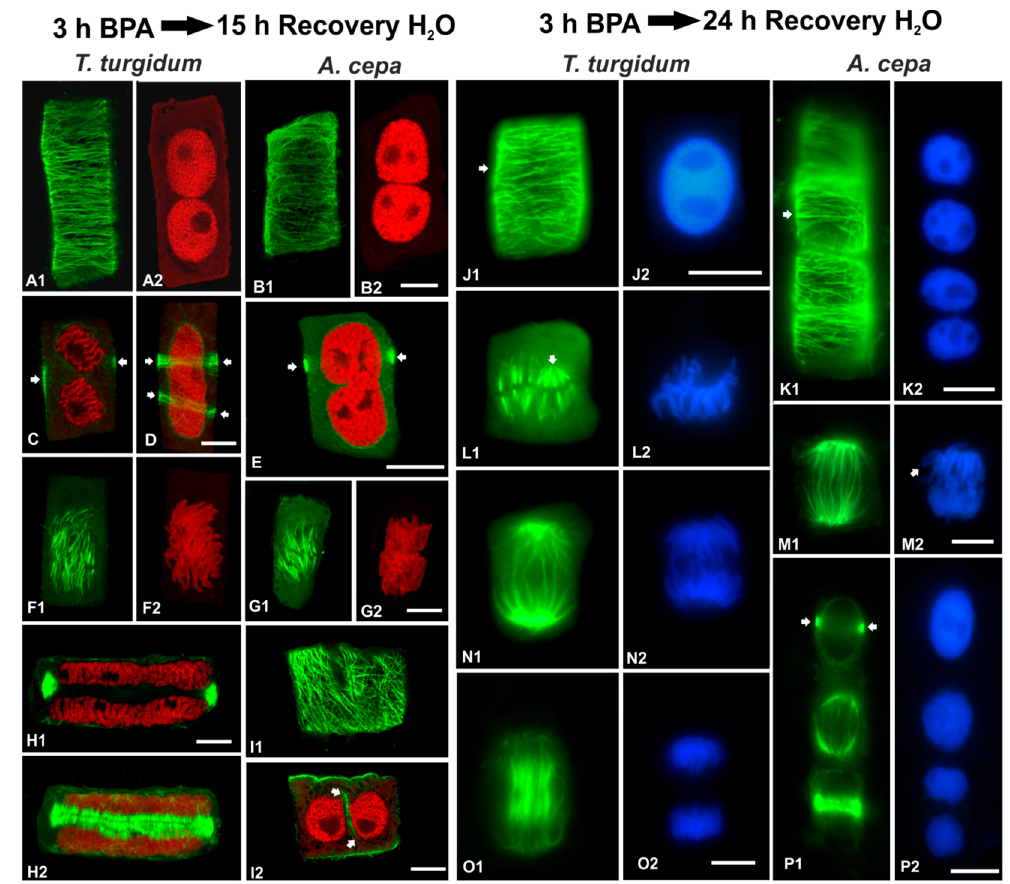
Figure 12. Tubulin immunolocalization (green, A1 , B1 , C–E , F1 , G1 , H , I , J1 , K1 , L1 , M1 , N1 , O1 , P1 ), propidium iodide DNA staining (red, A2 , B2 , C–E , F2 , G2 , H , I2 ) and DAPI DNA staining (blue, J2 , K2 , L2 , M2 , N2 , O2 , P2 ) in root cells recovering after BPA treatment. Arrows in ( C–E ) point to pre-prophase band profiles, arrows in ( I2 ) point to cell plate remnant in post-cytokinetic cell, arrows in ( J1 ) and ( K1 ) point to interphase microtubules, arrow in ( L1 ) points to a metaphase mini-pole, arrow in ( M2 ) points to chromosome arms diverging laterally, while arrows in ( P1 ) point to pre-prophase band profiles. Images ( A , B , F , H2 ) depict maximum projections of CLSM sections, images ( C–E , G , H1 , I ) are single CLSM sections, while images (J–P ) are conventional fluorescence micrographs. Scale bars: 10 μ m.